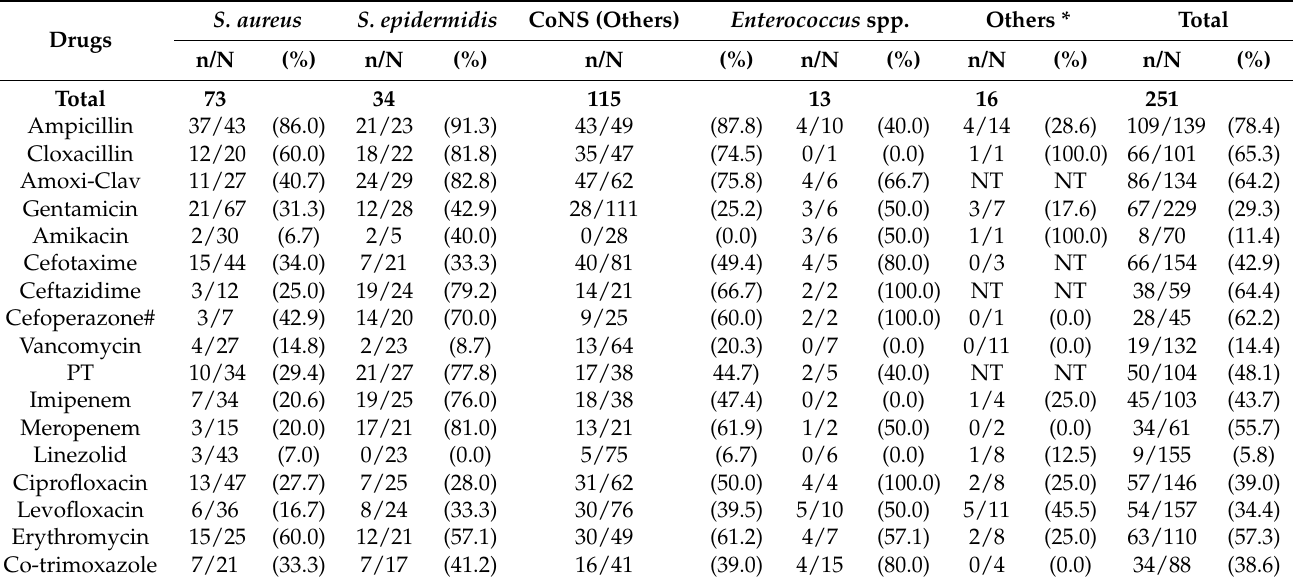
Table 4. Profile of Gram-positive isolates and antimicrobial resistance pattern among neonates with bacteriologically confirmed sepsis admitted to the NICU of two tertiary care hospitals in Yangon, Myanmar, January 2017 to December 2019. S. aureus S. Drugs